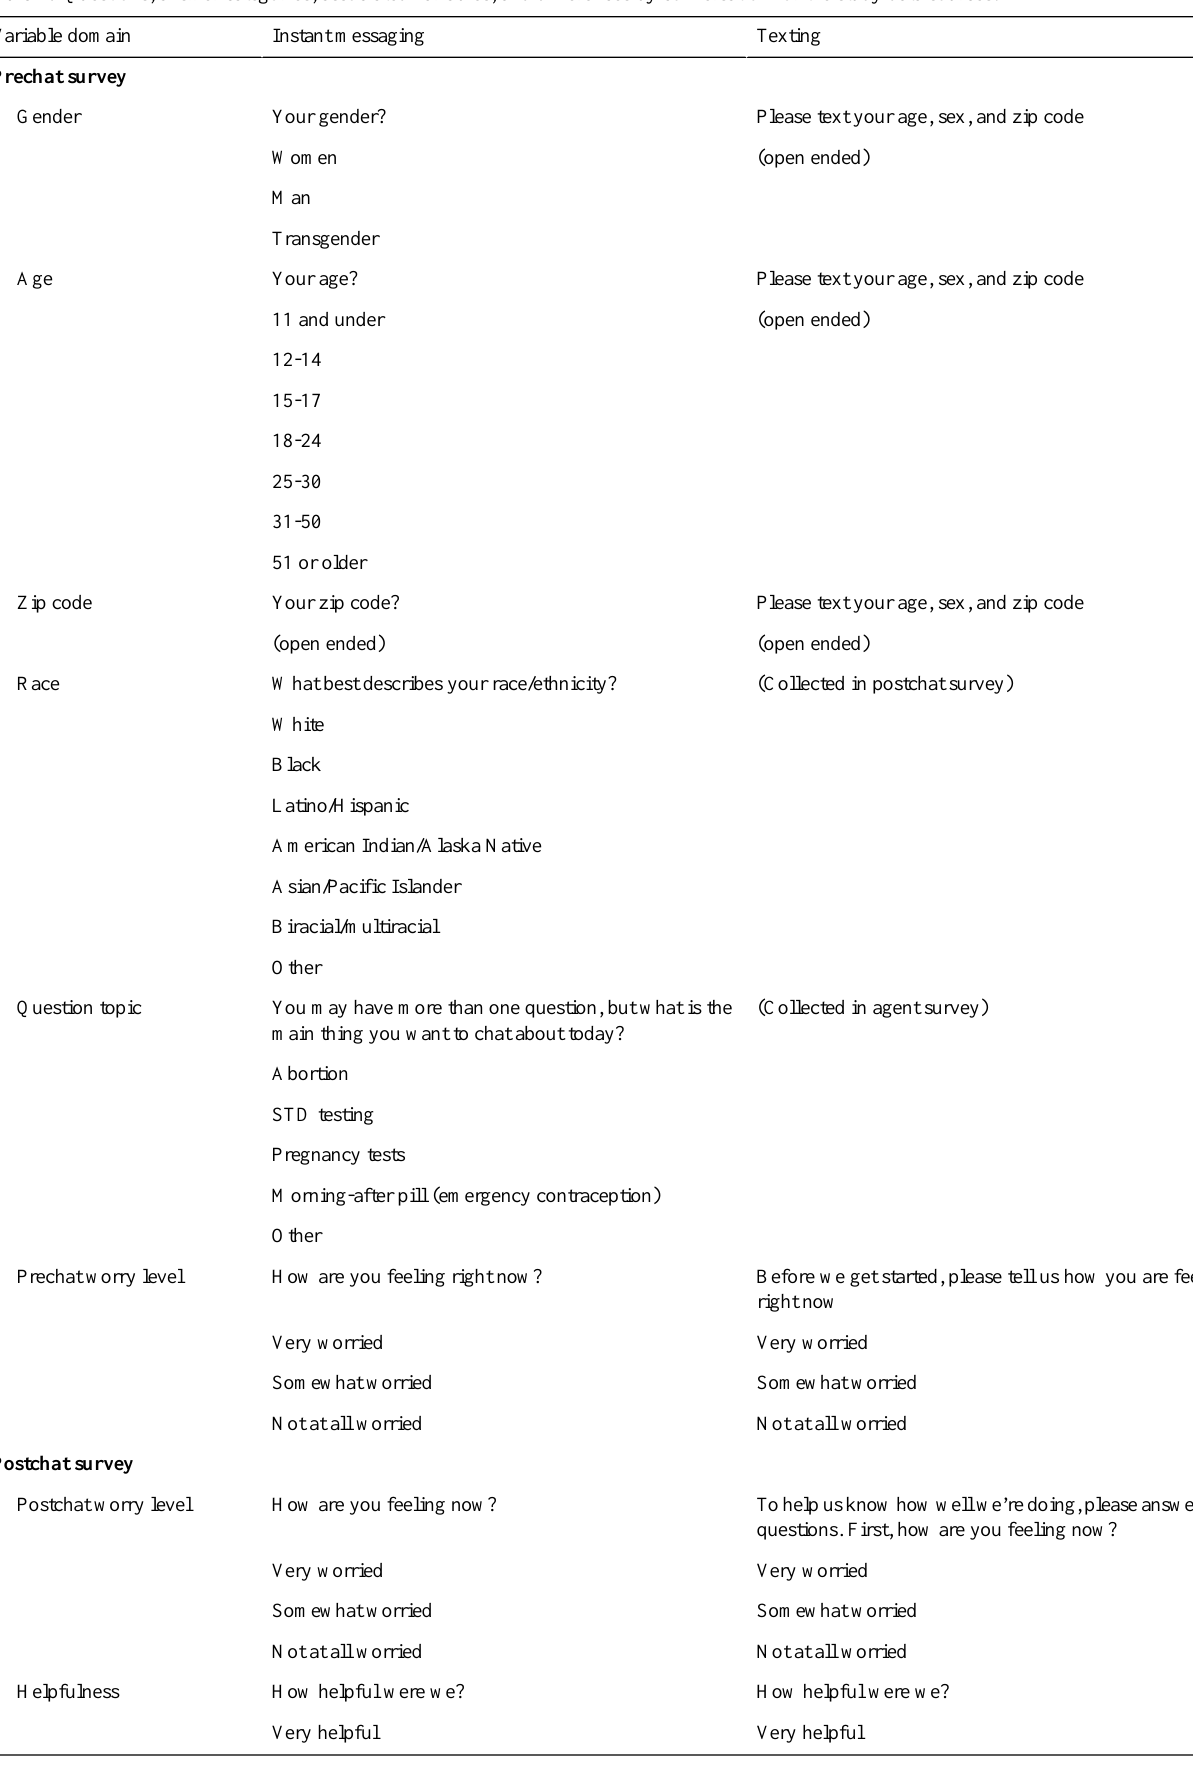
Table 1. Questions, answer categories, associated variables, and differences by conversation for the study data